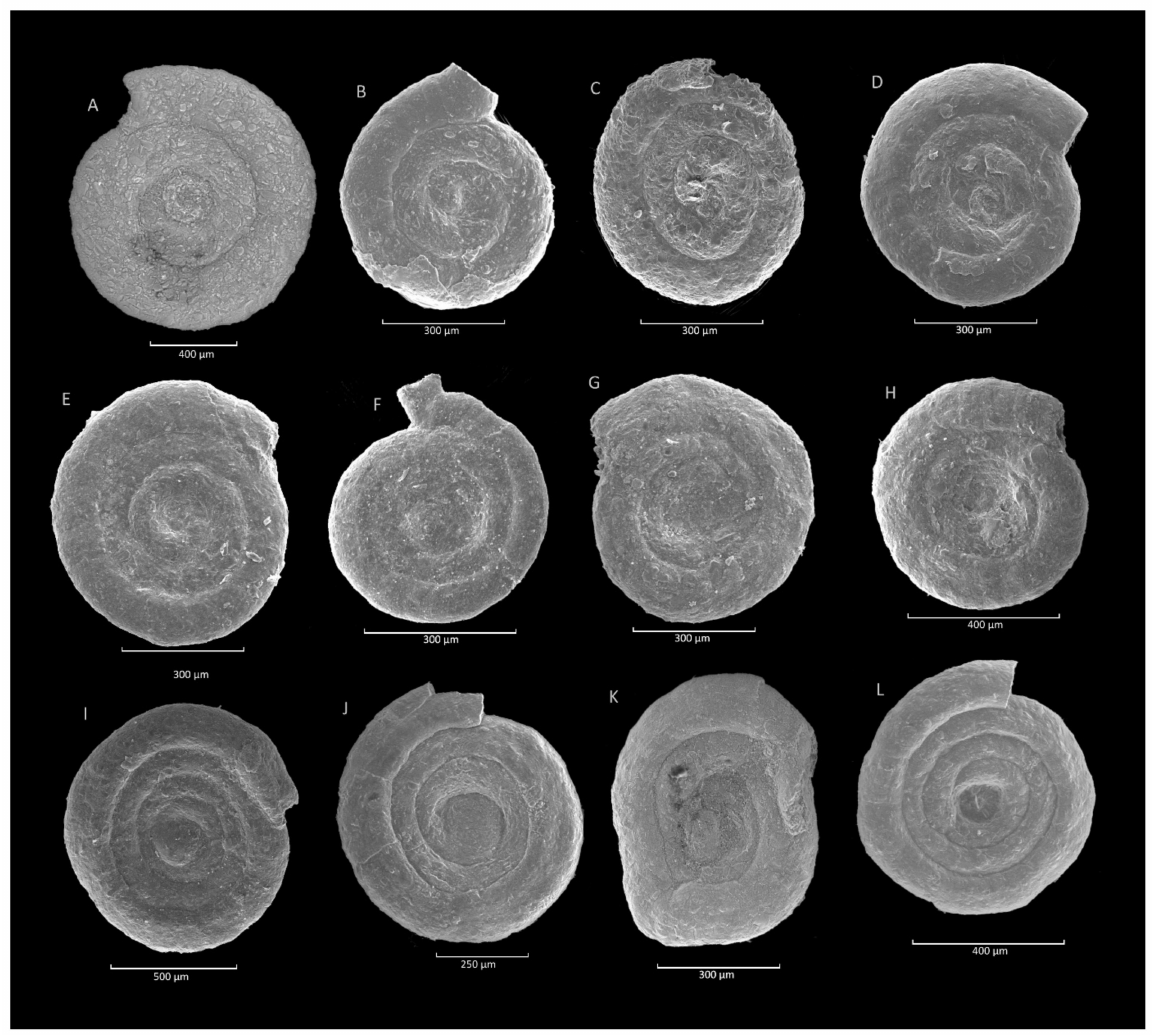
Figure 21. “Ammodiscus” latus (Grzybowski). ( A – C , E , F ): Krzesławice section; ( D , H , I ): Por˛eby-Czarnot ó wki section; ( G ): Leszczawa section; ( J – L ): Lipie